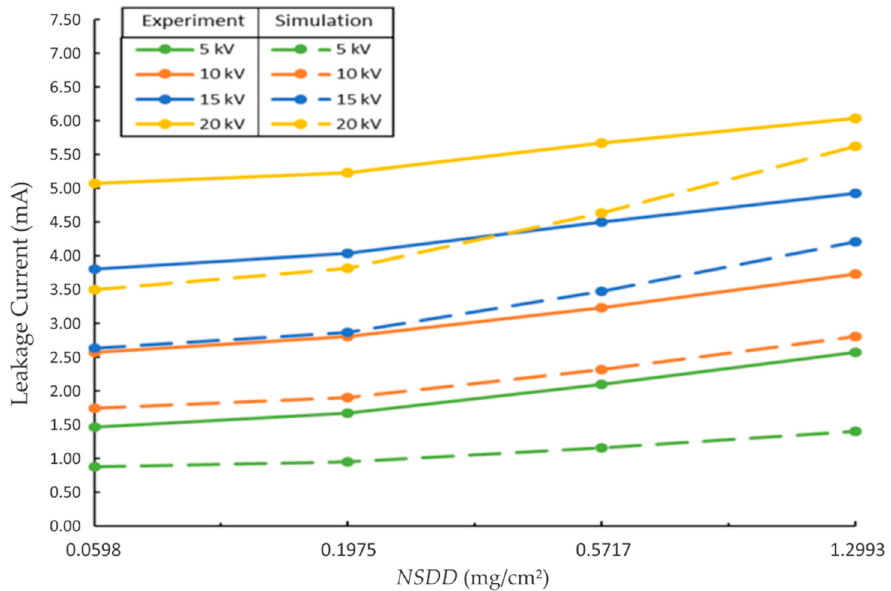
Figure 22. Comparison of the leakage current from the simulation results with the test on fly ash.